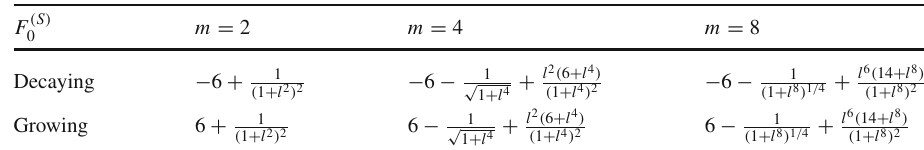
Table 5 F ( S ) for 0 f ( y ) = − log [ cosh ( y / y 0 ) ] (first row) and f ( y ) = + log [ cosh ( y / y 0 ) ] (second row) at y = 0 with